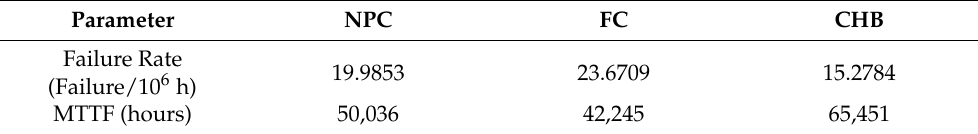
Table 9. The Mean time to failure calculated with respect to various multilevel inverters. Parameter